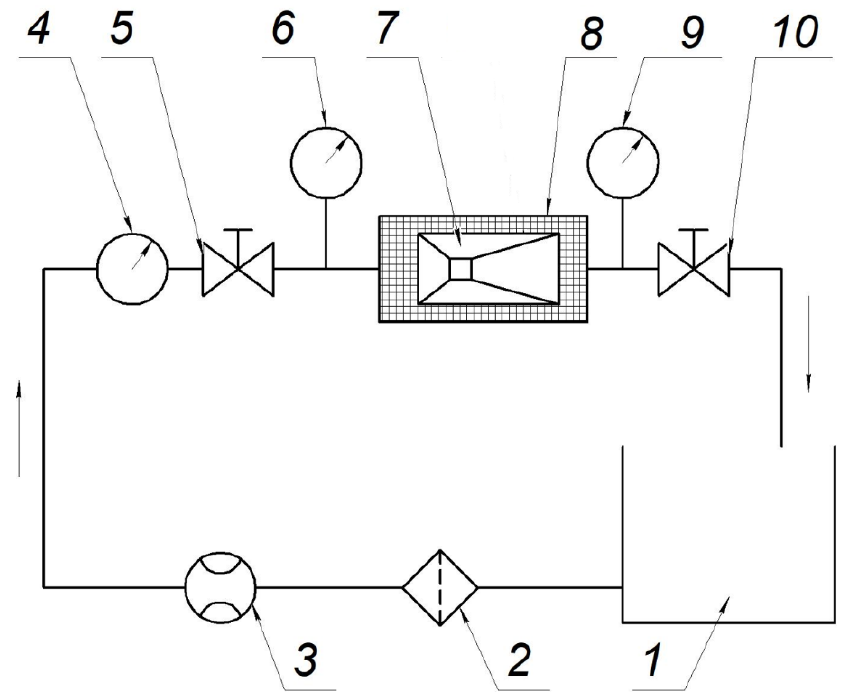
Figure 1. Diagram of experimental installation of audiovisual determination of cavitation parameters.